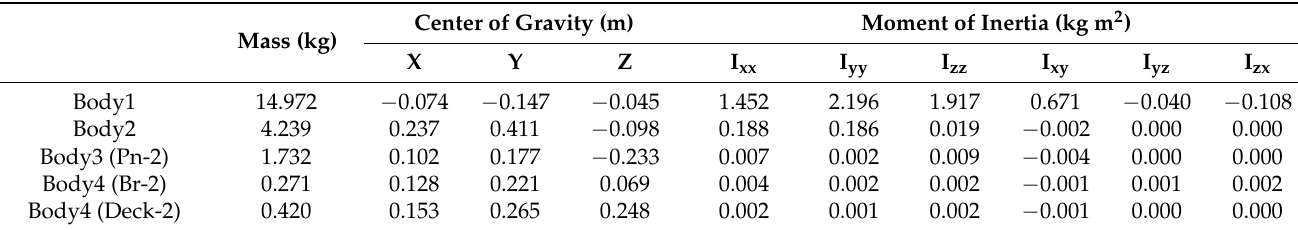
Table 3. Structural properties of each